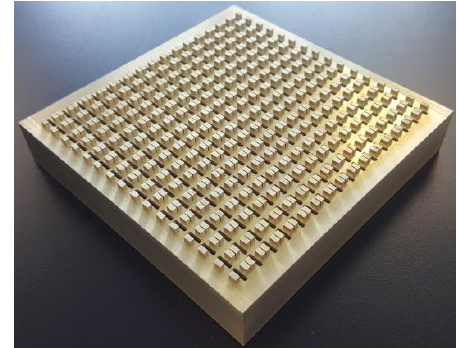
Figure 3. Prototype of the 3D view of 16 × 16 complementary dipole antenna array made of pure aluminum.